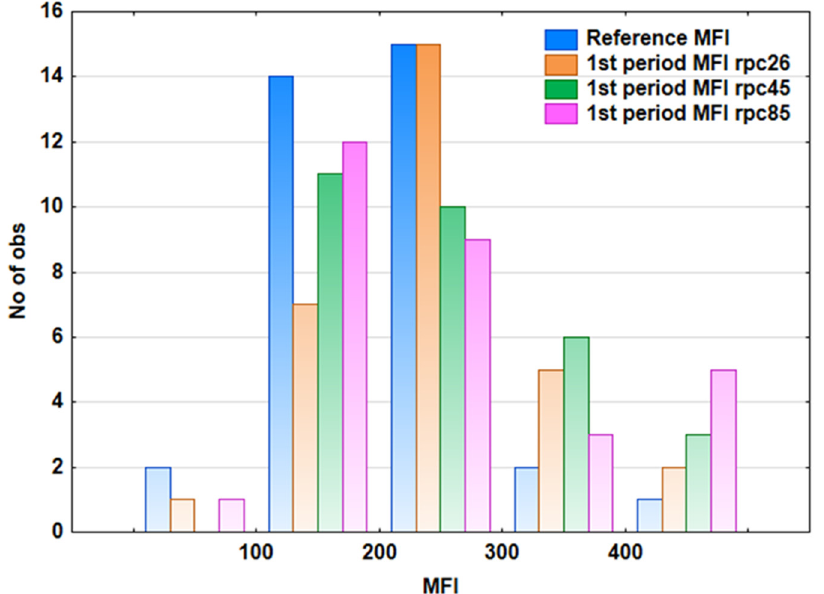
Figure 13. Distribution of MFI values in the reference period and the first-period climate scenarios.